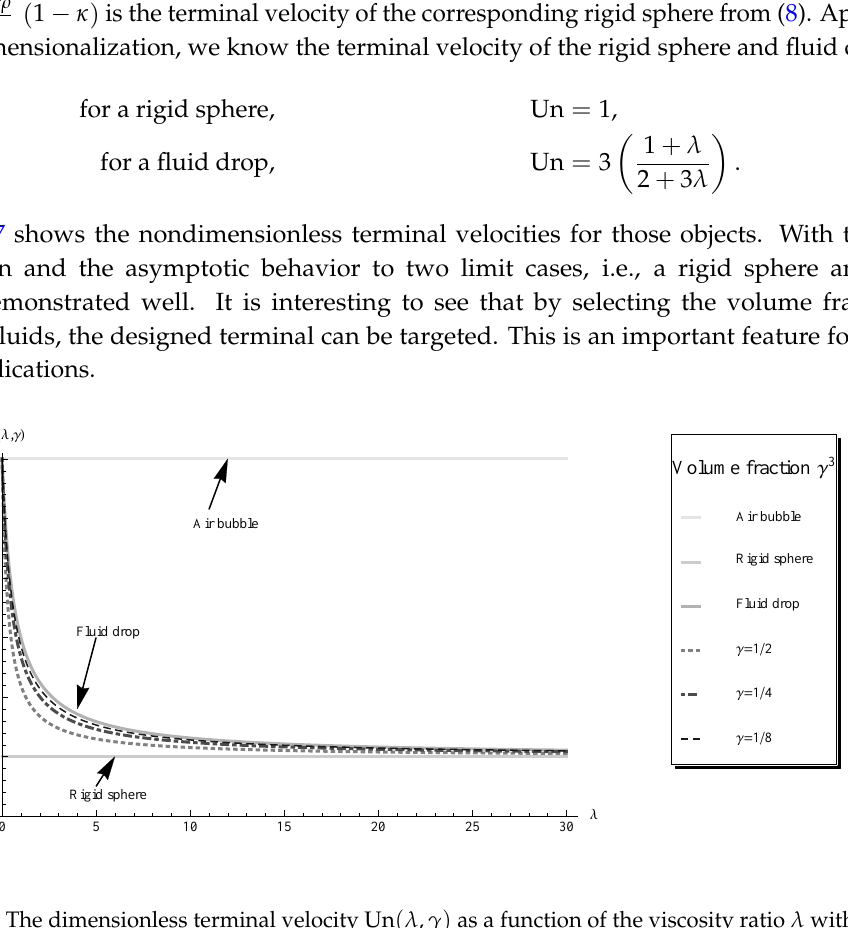
Figure 7. The dimensionless terminal velocity Un ( λ , γ ) as a function of the viscosity ratio λ with fixed volume fraction γ 3 . The densities of the fluid in the coating and the rigid kernel are set be the same as the mean density ρ mean . The radii of the two-layer object, the rigid sphere, the fluid drop, and the air bubble are the same. The air bubble result is obtained by taking the viscosity ratio λ = ¯ µ / µ = 0 for the fluid